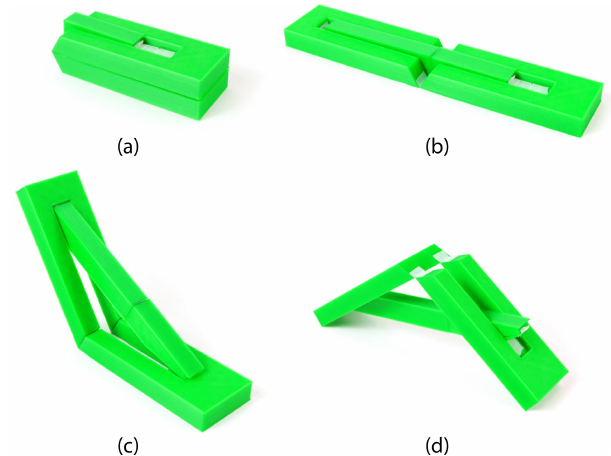
Figure 12. Flat-foldable planar deploying strut ThUDS with strut (link 3) split. Shown as (a) flat folded, (b) flat, (c) deployed, and (d) in an undesired state due to the added degree of freedom.